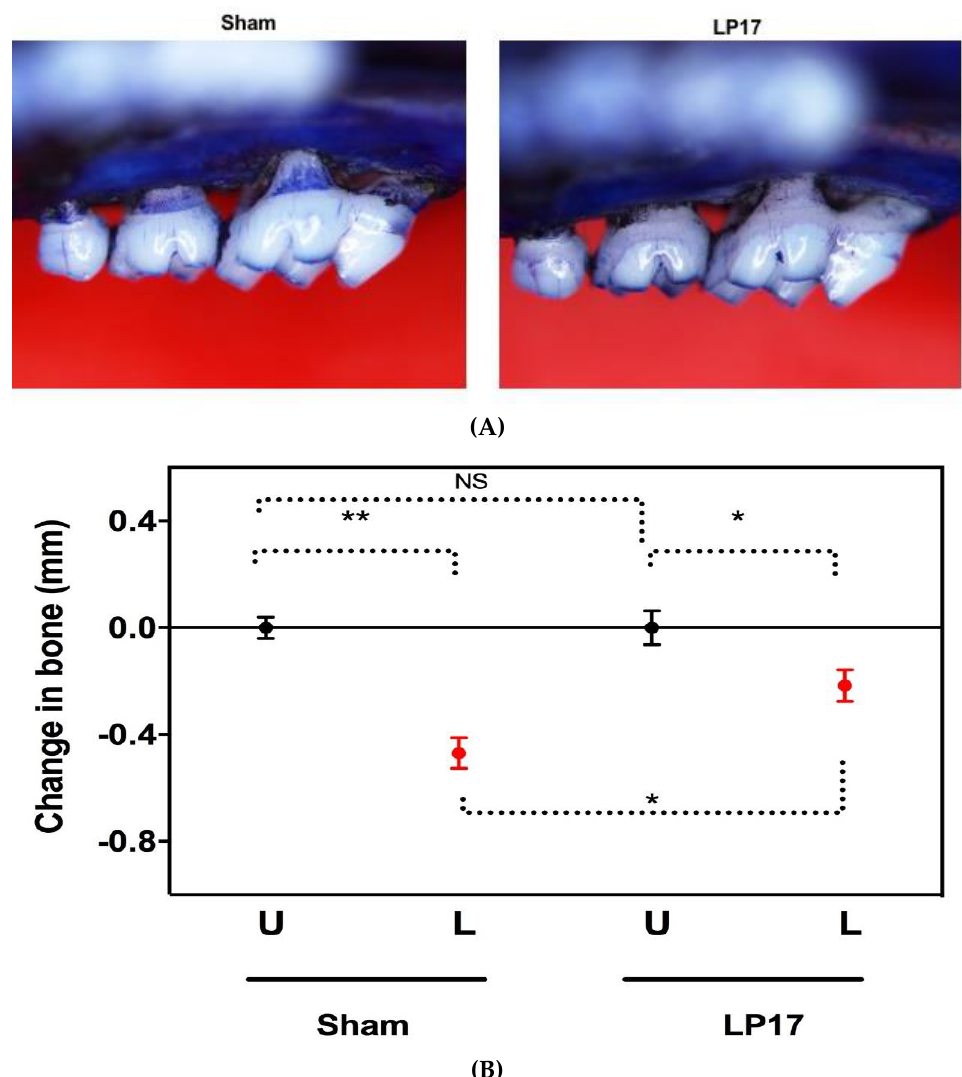
Figure 2. Inhibition of ligature-induced bone loss by LP17. Ligatures were placed on the left maxillary molars of C57BL / 6 mice and then locally microinjected with 5 µ g of TREM-1 blocking peptide (LP17) or with PBS sham 1 day before placing the ligature and every day thereafter until day 5. The distance between the cemento-enamel junction (CEJ) and alveolar bone crest (ABC) was measured at six predetermined points on the ligated side. Representative images of PBS sham- and LP17-treated maxillae exhibiting differential bone loss (A). To calculate bone loss, the six-site total CEJ–ABC distance for the ligated (L) side of each mouse was subtracted from the six-site total CEJ–ABC distance of the contralateral unligated (U) side. The results are presented in millimeters, and negative values indicate bone loss relative to the unligated control (B) . Data are means ± SEM ( n = 4–5 mice/group). * p < 0.05 and ** p < 0.01 between the indicated groups.